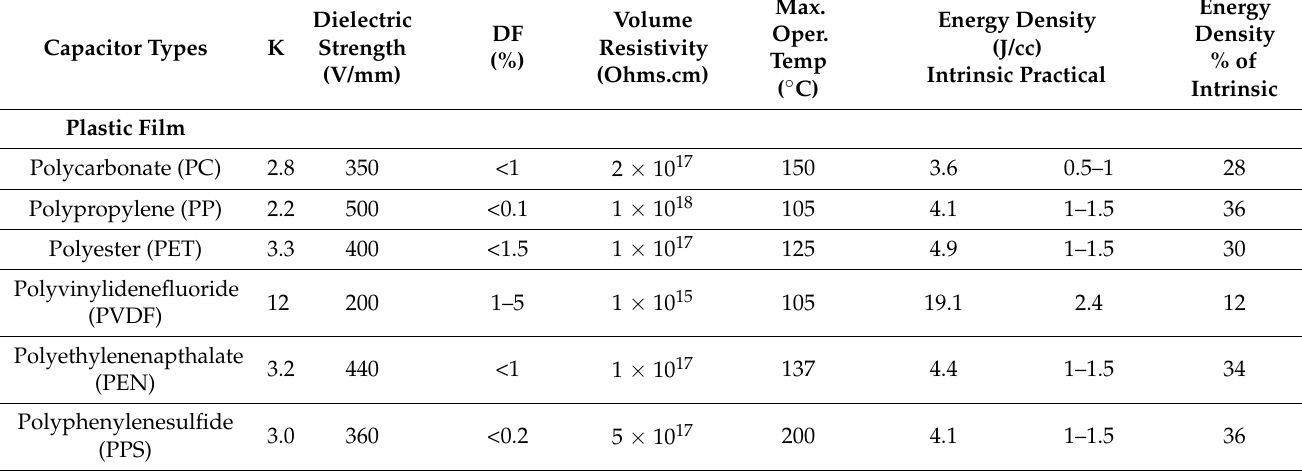
Table 5. Characteristics of possible host polymers